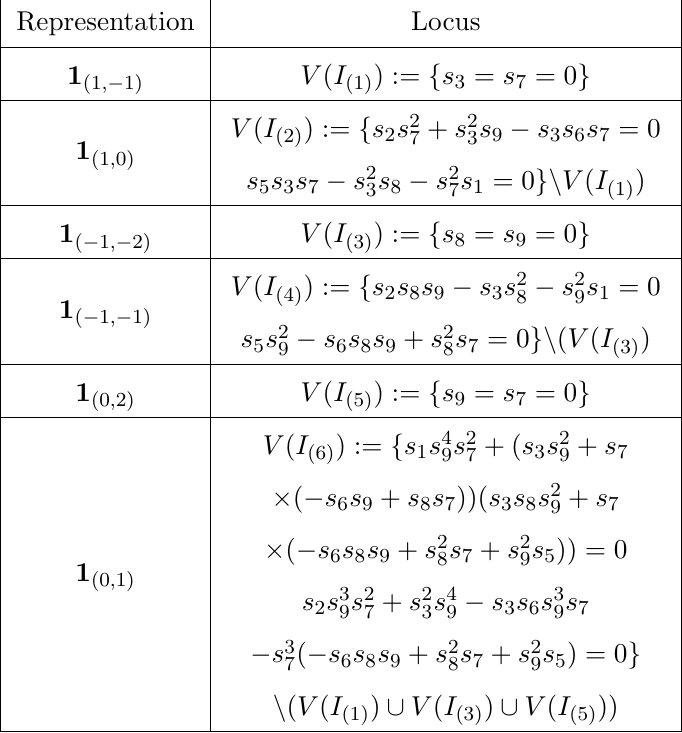
Table 9 . Charged singlets under U(1) 2 with the expressions for their corresponding codimension- two